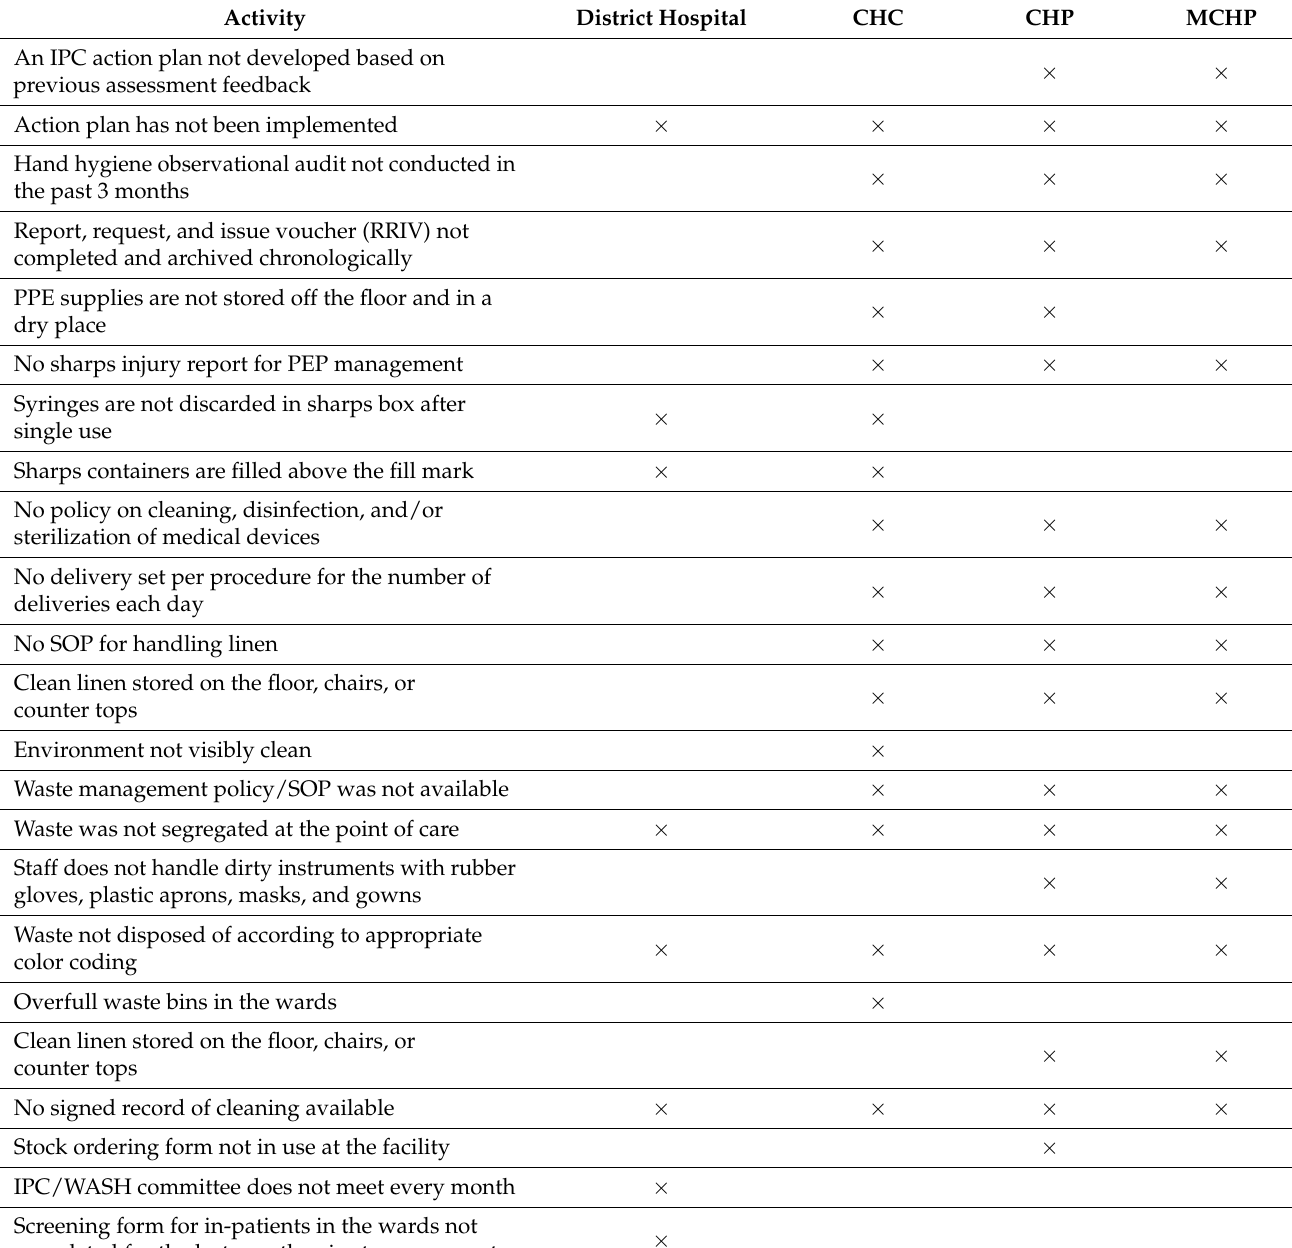
Table 5. Gaps in specific activities for Kenema district hospital and Peripheral Health Units, Sierra Leone (2018). (Blank spaces = no identified gap; × = gap